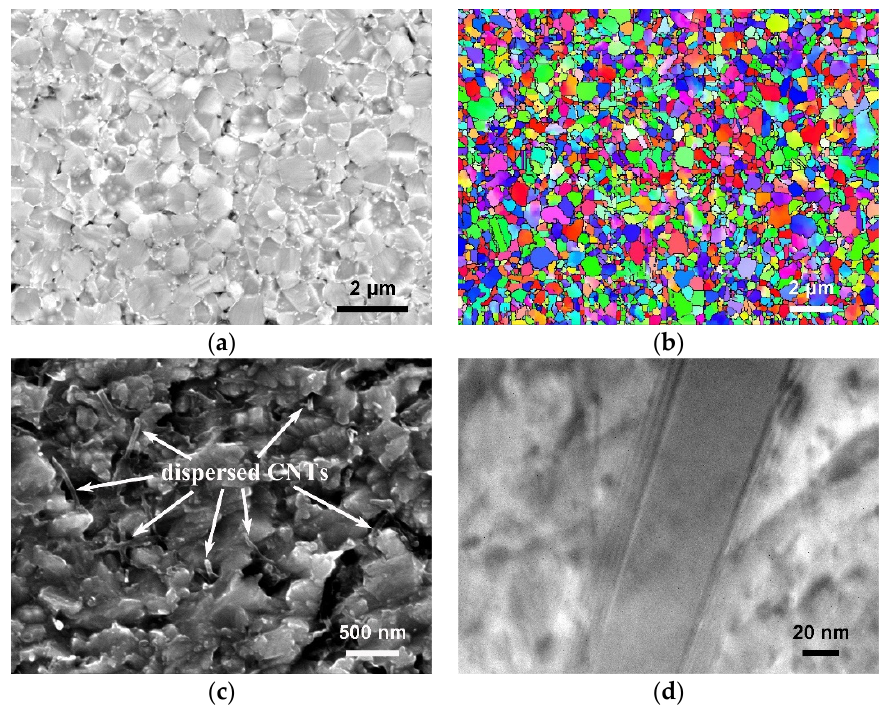
Figure 4. Microstructure of sample prepared by HOP at 550 ◦ C. ( a ) SEM and ( b ) EBSD images showing microstructure. ( c ) SEM image of over-etched sample showing distribution of CNTs. ( d ) TEM image of a CNT in the Cu